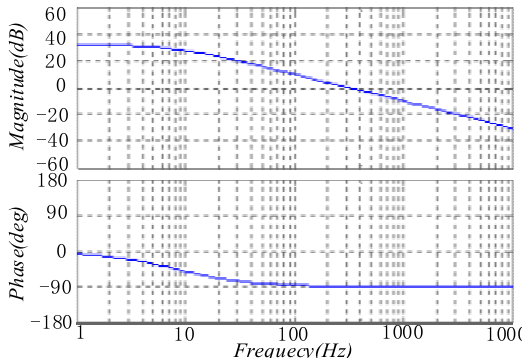
Figure 14. The bode diagram of LLC resonant converter’s input impedance model. Figure 14. T he bode diagram of LLC resonant converter’s input impedance model.